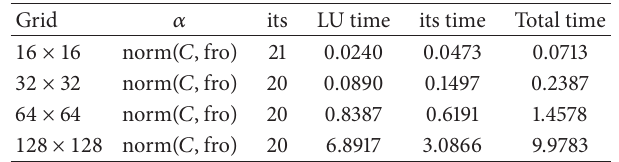
Table 3: Preconditioned GMRES(20) on steady Oseen problems with different grid sizes (uniform grids), viscosity V = 0.01 .